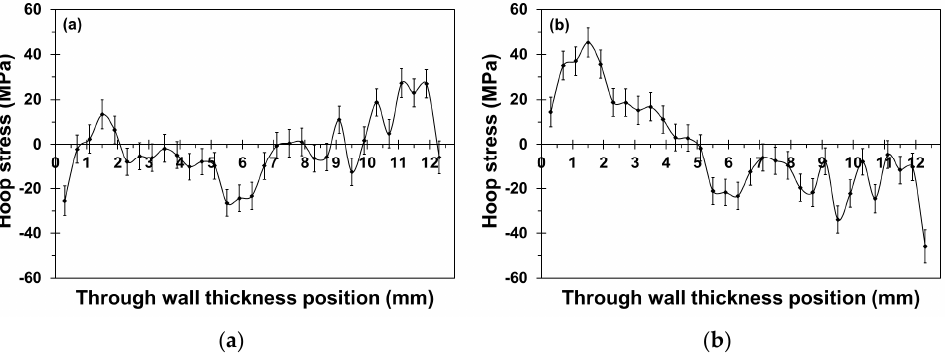
Figure 4. Residual stresses profiles in the hoop direction for the X52 steel: ( a ) Measured for the sample cut out of the pipe ring; ( b ) Plotted including the bending pipe linear distribution stress.